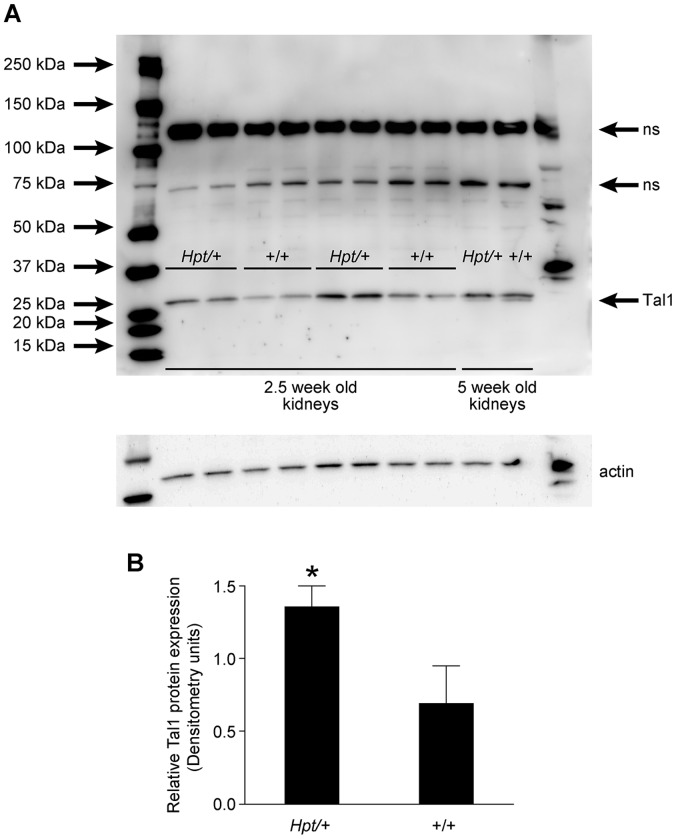
Tal1 protein levels in kidney tissues.Western blot analysis of kidney tissues from 2.5- and 5-week-old +/+ and Hpt/+ mice. 40 µg of protein was loaded onto each lane, and probed with c-terminal Tal1-specific antibody. A subtle but significant increase in Tal1 protein levels was observed in 2.5-week-old Hpt/+ mice compared with +/+ control mice, however we did not detect any shortened protein products using this antibody. Actin was used as a loading control. ns, non-specific bands (A). Densitometry quantification of Tal1 protein expression in the kidneys of 2.5-week-old Hpt/+ and +/+ mice (B). *p<0.05.